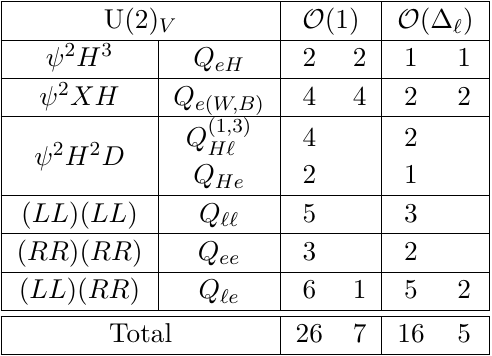
Table 9 . Counting of the pure lepton SMEFT operators (see appendix A) assuming U(2) vectorial symmetry in the lepton sector. The counting is performed taking up to one insertion of ∆ ‘ spurion. The left (right) entry in each column gives the number of CP even (odd) coefficients at the given order in spurion